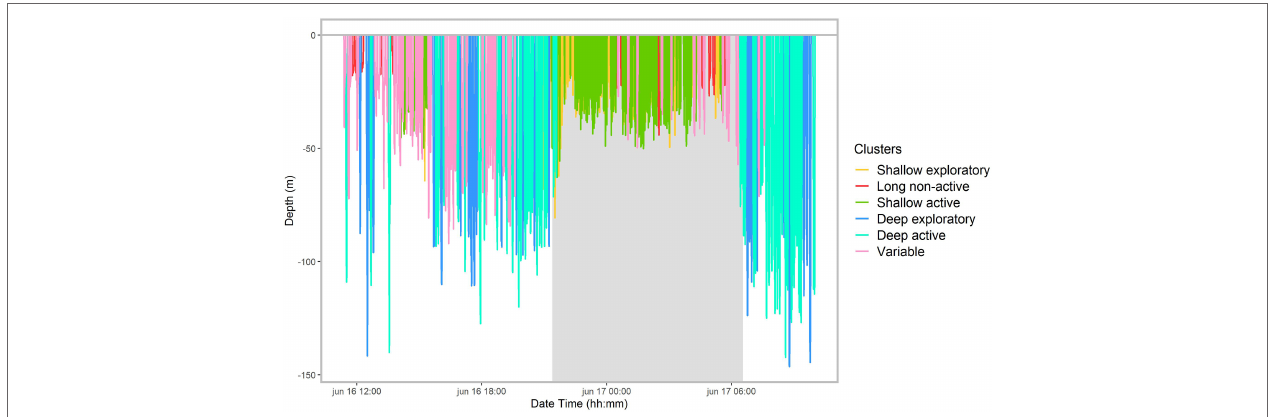
FIGURE 6 | Dive profile of whale #16 illustrating the diel pattern in diving behavior and dive types, as identified by the cluster analysis. The shaded area indicates the night